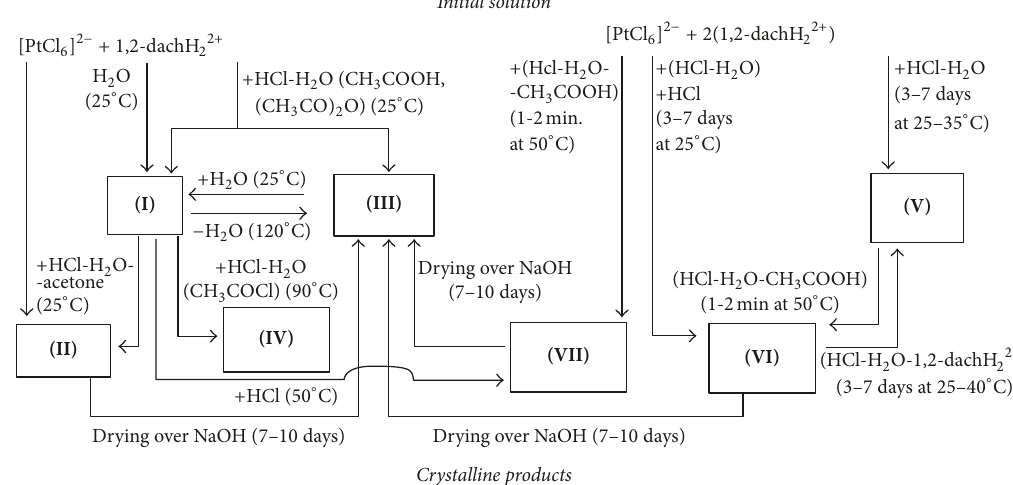
Figure 1: The integrated scheme of phase (I) – (VII) crystallization depending on synthesis conditions. (I) C 6 H 10 (NH 3 ) 2 [PtCl 6 ] ⋅ H 2 O, (II) C 6 H 10 (NH 3 ) 2 [PtCl 6 ] ⋅ 2H b l, (III) C 6 H 10 (NH 3 ) 2 [PtCl 6 ], (V) (C 6 H 10 (NH 3 ) 2 ) 2 [PtCl 6 ]Cl 2 , and (VI) C 6 H 10 (NH 3 ) 2 [PtCl 6 ] ⋅ H b